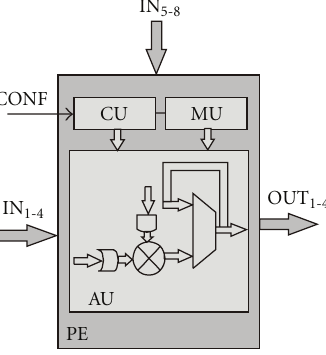
Figure 8: Architecture of the PE cell.